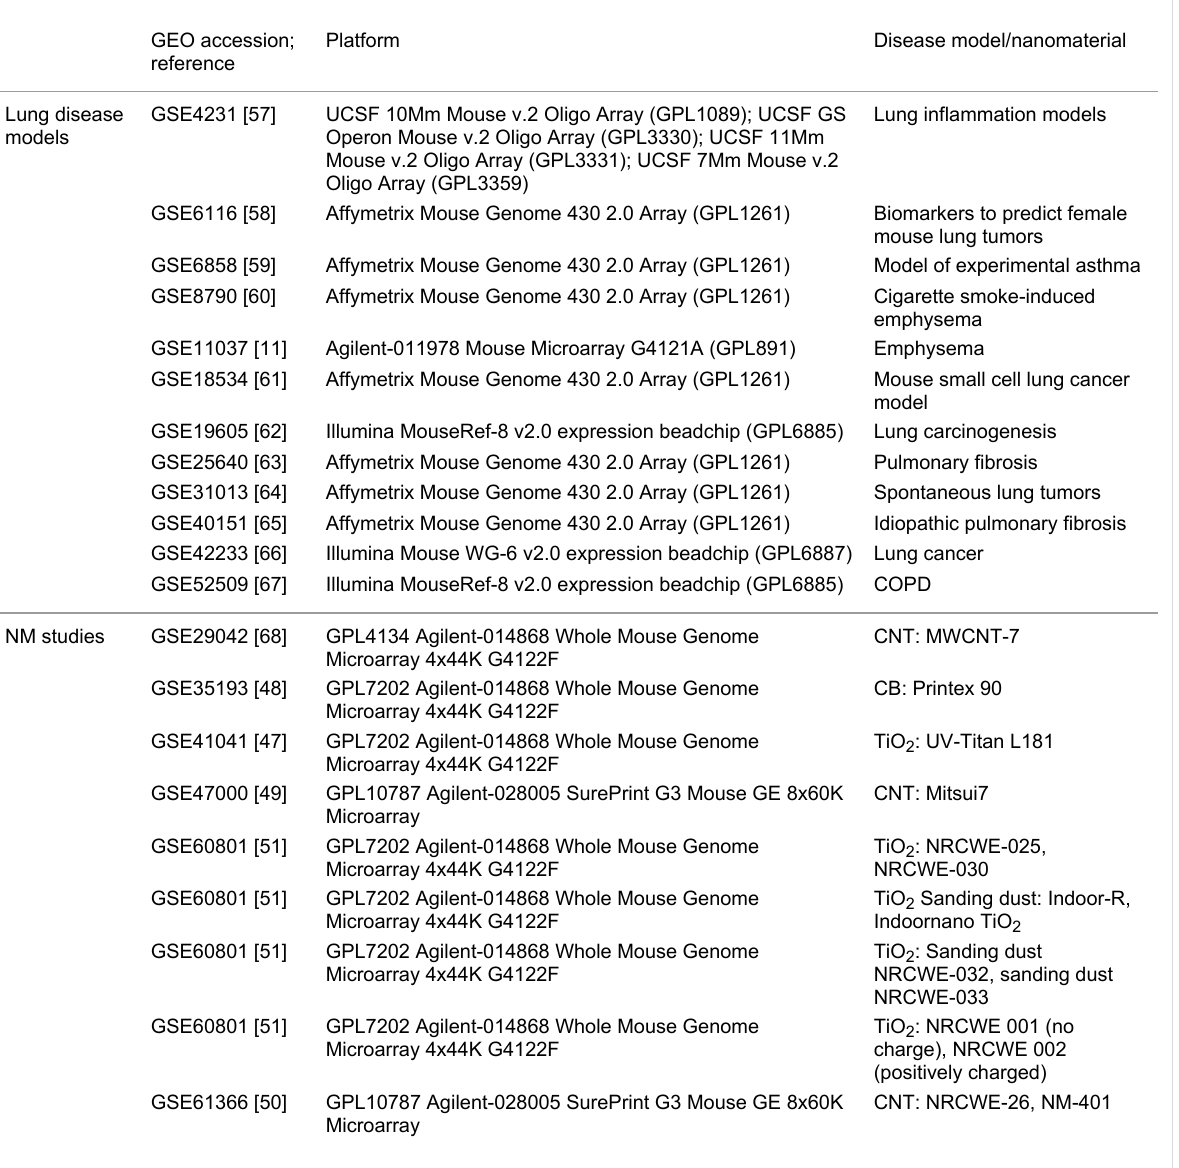
Table 1: Publically available